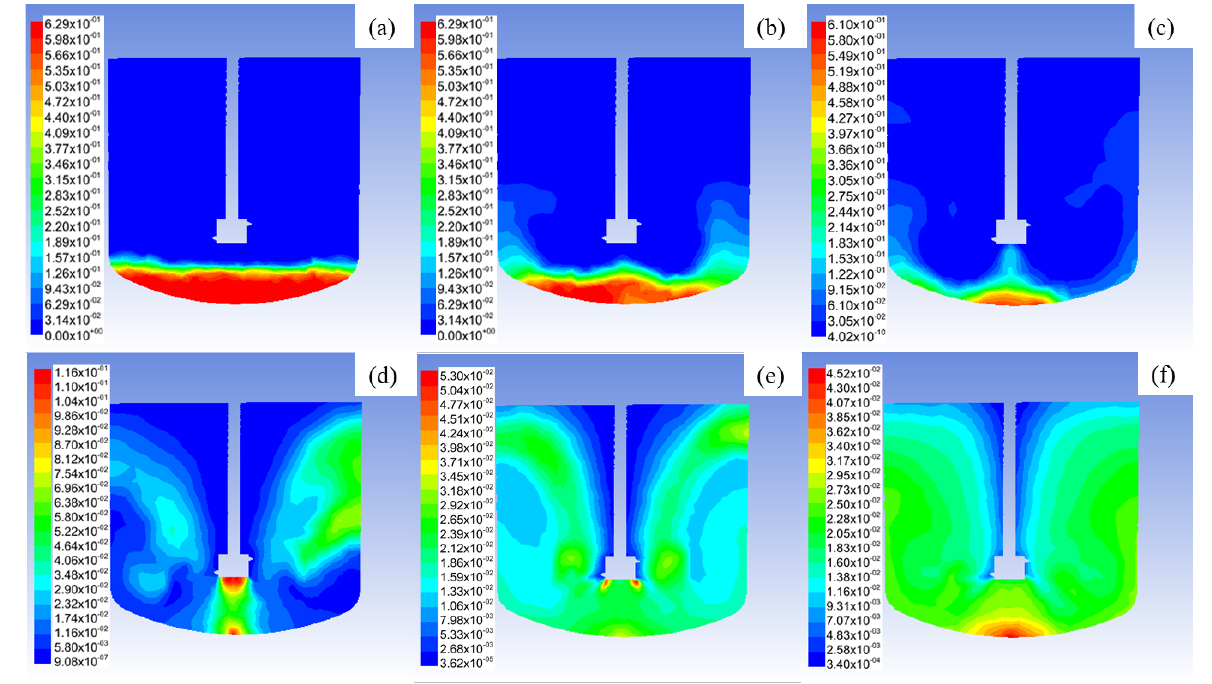
Figure 4. Volume fraction distribution of solid phase at N = 200 rpm. ( a ) t = 0 s; ( b ) t = 2 s; ( c ) t = 4 s; ( d ) t = 6 s; ( e ) t = 8 s; ( f ) t = 10 s.